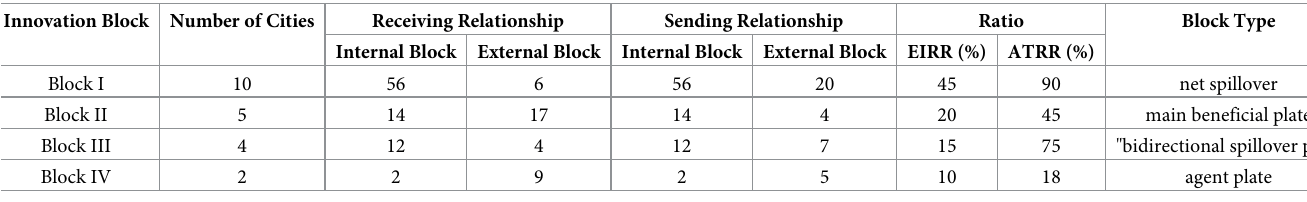
Table 11. Division of blocks.